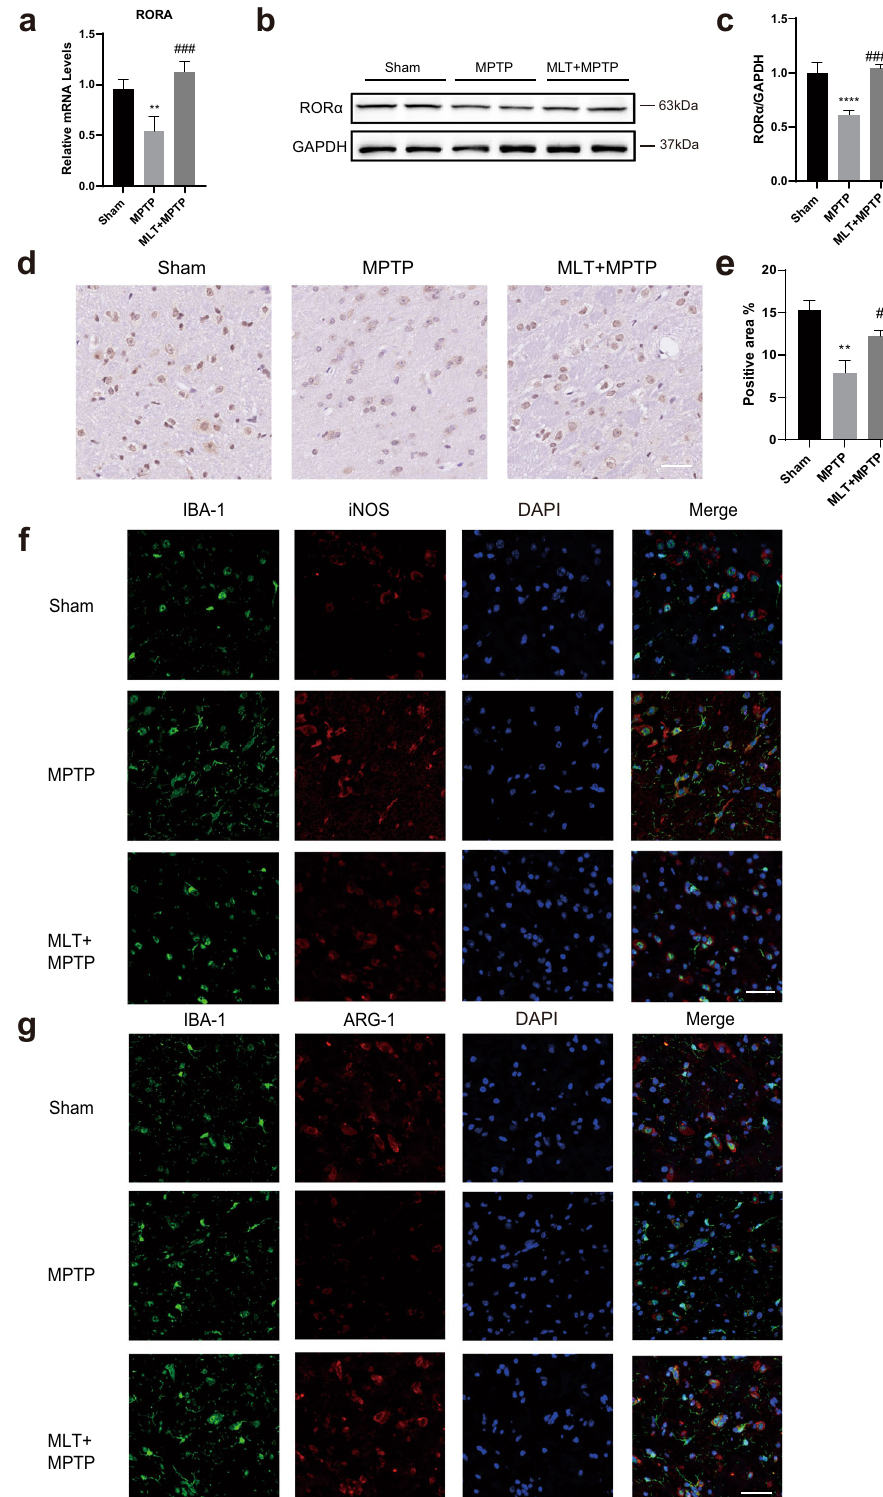
Fig. 4 MLT treatment improved ROR α expressions and directed microglia cells toward anti-in fl ammatory M2-like phenotype in vivo. The mice in MLT group were pre-treated with MLT (20 mg/kg, i.p.) half an hour before MPTP (25 mg/kg, i.p.) injection. MPTP, MLT or equivalent saline were applied for 7 days. a Relative mRNA levels of ROR α in midbrain tissues were determined by RT-qPCR. b , c Protein expressions of ROR α in midbrain tissue. The protein expressions were normalized to GAPDH. d , e Representative immunohistochemical images of ROR α in SN. Semi- quanti fi cation of ROR α protein level was presented as positive area. Scale bars = 50 μ m. f , g Representative immuno fl uorescent staining images of IBA-1 (green), iNOS (red) and ARG-1 (red) in SN. Blue indicates nuclei. Scale bars = 50 μ m. Data were average with error bars representing standard deviation. ( n = 5 per group. *, #, P < 0.05; **, ##, P < 0.01; ***, ###, P < 0.001; ****, ####, P < 0.0001; *, vs Sham group; #, vs MPTP